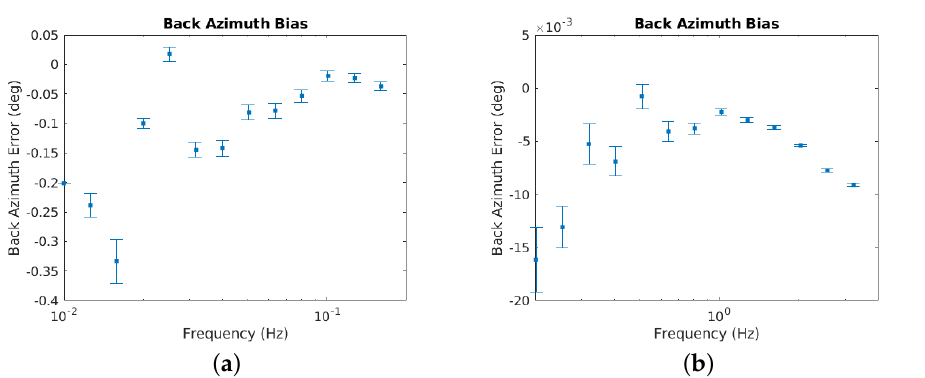
Figure 12. Back azimuth error (bias) due to filtering in TDOA. The error bars represent the standard deviation of the back azimuth errors. ( a ) Frequency lower than 0.2 Hz. ( b ) Frequency higher than 0.2